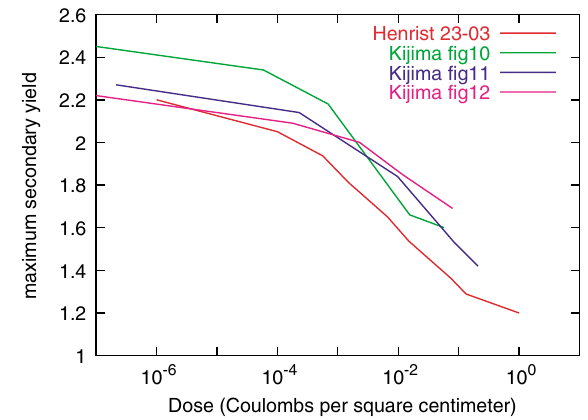
FIG. 10. (Color) Data obtained from Henrist et al. [43] and Kijima et al. [44] by using a ruler to measure the data points on the published graphs. The Henrist et al. data is labeled curve 23-03 in their Fig. 1. The data from Kijima et al. are all for (cid:5) 600 eV . Kijima’s Figs. 10, 11, and 12 were for OFHC, E strike Cu-plated stainless steel, and Nb, respectively.